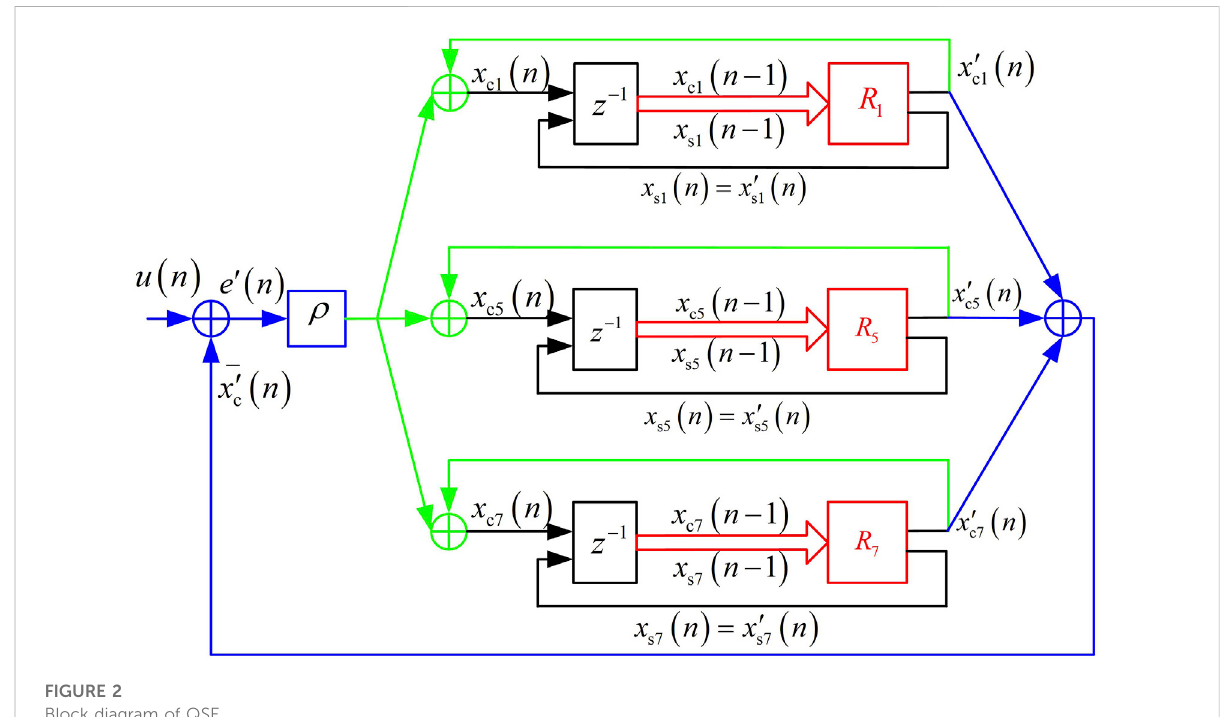
FIGURE 2 Block diagram of QSE.